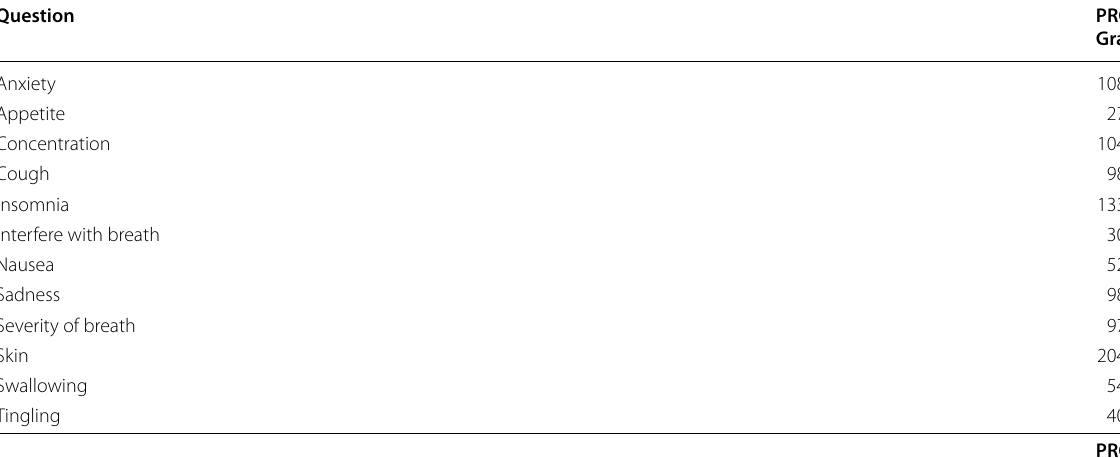
2 and 3 at any time ≥ ≥